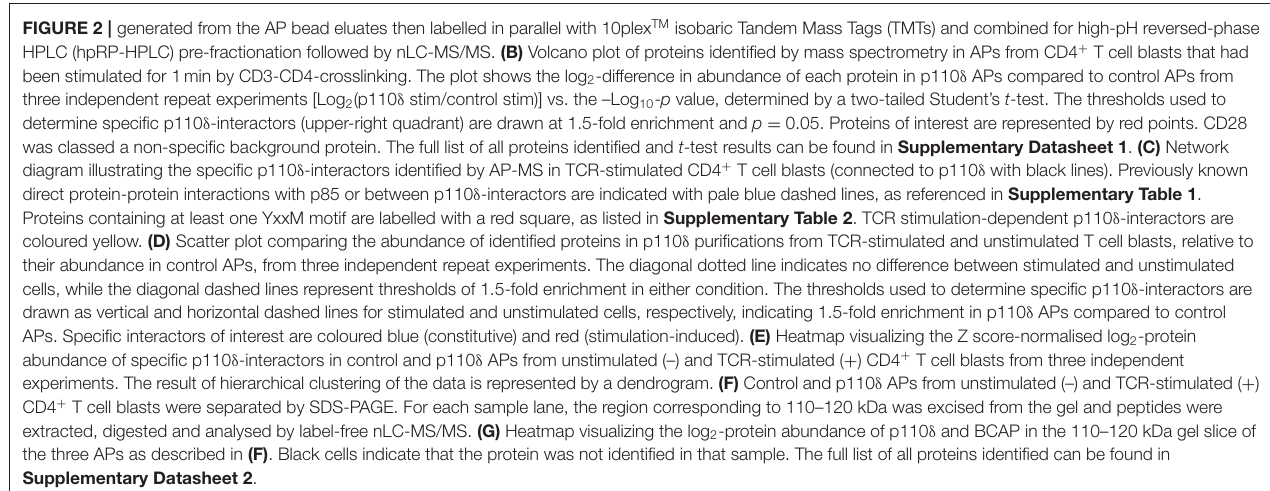
FIGURE 2 | generated from the AP bead eluates then labelled in parallel with 10plex TM isobaric Tandem Mass Tags (TMTs) and combined for high-pH reversed-phase HPLC (hpRP-HPLC) pre-fractionation followed by nLC-MS/MS. (B) Volcano plot of proteins identified by mass spectrometry in APs from CD4 + T cell blasts that had been stimulated for 1min by CD3-CD4-crosslinking. The plot shows the log 2 -difference in abundance of each protein in p110 δ APs compared to control APs from three independent repeat experiments [Log 2 (p110 δ stim/control stim)] vs. the –Log 10 - p value, determined by a two-tailed Student’s t -test. The thresholds used to determine specific p110 δ -interactors (upper-right quadrant) are drawn at 1.5-fold enrichment and p = 0.05. Proteins of interest are represented by red points. CD28 was classed a non-specific background protein. The full list of all proteins identified and t -test results can be found in Supplementary Datasheet 1 . (C) Network diagram illustrating the specific p110 δ -interactors identified by AP-MS in TCR-stimulated CD4 + T cell blasts (connected to p110 δ with black lines). Previously known direct protein-protein interactions with p85 or between p110 δ -interactors are indicated with pale blue dashed lines, as referenced in Supplementary Table 1 . Proteins containing at least one YxxM motif are labelled with a red square, as listed in Supplementary Table 2 . TCR stimulation-dependent p110 δ -interactors are coloured yellow. (D) Scatter plot comparing the abundance of identified proteins in p110 δ purifications from TCR-stimulated and unstimulated T cell blasts, relative to their abundance in control APs, from three independent repeat experiments. The diagonal dotted line indicates no difference between stimulated and unstimulated cells, while the diagonal dashed lines represent thresholds of 1.5-fold enrichment in either condition. The thresholds used to determine specific p110 δ -interactors are drawn as vertical and horizontal dashed lines for stimulated and unstimulated cells, respectively, indicating 1.5-fold enrichment in p110 δ APs compared to control APs. Specific interactors of interest are coloured blue (constitutive) and red (stimulation-induced). (E) Heatmap visualizing the Z score-normalised log 2 -protein abundance of specific p110 δ -interactors in control and p110 δ APs from unstimulated (–) and TCR-stimulated ( + ) CD4 + T cell blasts from three independent experiments. The result of hierarchical clustering of the data is represented by a dendrogram. (F) Control and p110 δ APs from unstimulated (–) and TCR-stimulated ( + ) CD4 + T cell blasts were separated by SDS-PAGE. For each sample lane, the region corresponding to 110–120 kDa was excised from the gel and peptides were extracted, digested and analysed by label-free nLC-MS/MS. (G) Heatmap visualizing the log 2 -protein abundance of p110 δ and BCAP in the 110–120 kDa gel slice of the three APs as described in (F) . Black cells indicate that the protein was not identified in that sample. The full list of all proteins identified can be found in Supplementary Datasheet 2